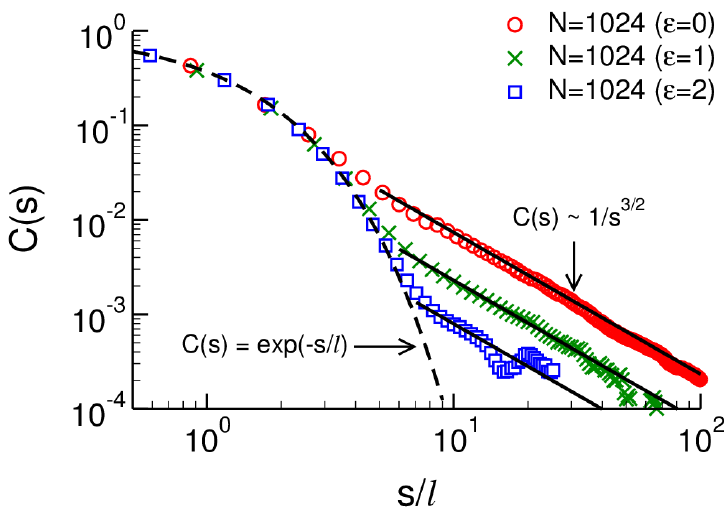
Figure 4. Log-log plot of the tangent/tangent correlation function C ( s ) = (cid:104) cos θ ( s ) (cid:105) versus arc-length s for a 3D polymer melt with chains of length N = 1024. The symbols show data from MD simulations for a Kremer–Grest-like bead-spring model [10] with three bending penalties: (cid:101) = 0,1,2. The model is similar to the one shown in Figure 2. Thus, the melt with (cid:101) ≤ 2 is isotropic, the value (cid:101) = 0 corresponding to fully-flexible chains. The abscissa is scaled by the persistence length (cid:96) obtained from a fit of the initial decay of C ( s ) to Equation (1); see the dashed line in the figure. The solid lines indicate the power law, C ( s ) ∼ s − 3/2 , expected from corrections to chain ideality